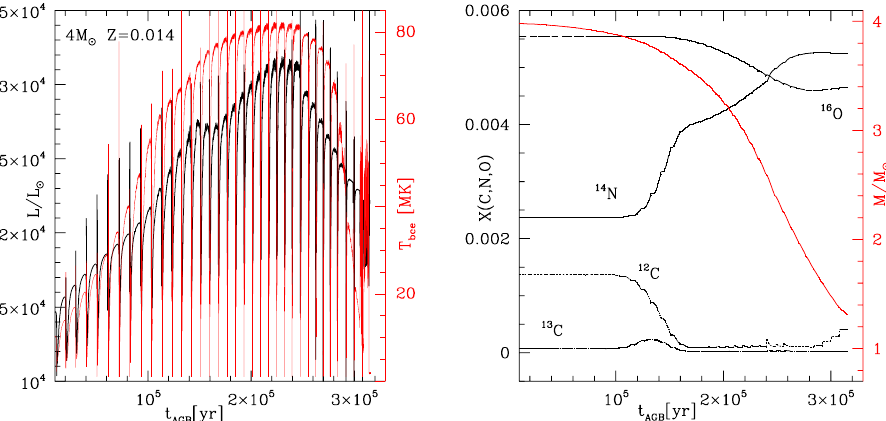
Figure 2. ( Left ) Time variation of the luminosity (black, scale in the left) and of the temperature at the bottom of the convective envelope (red, scale on the right) of a 4 M (cid:12) model star of metallicity Z = 0.014, during the AGB phase. ( Right ) Time variation of the surface 12 C (dotted line), 13 C (dotted- dashed line), 14 N (solid), 16 O (dashed), and of the mass of the stars (red track, scale on the right) of the same model star shown in the left